Question: Give a one-sentence summary of this figure.
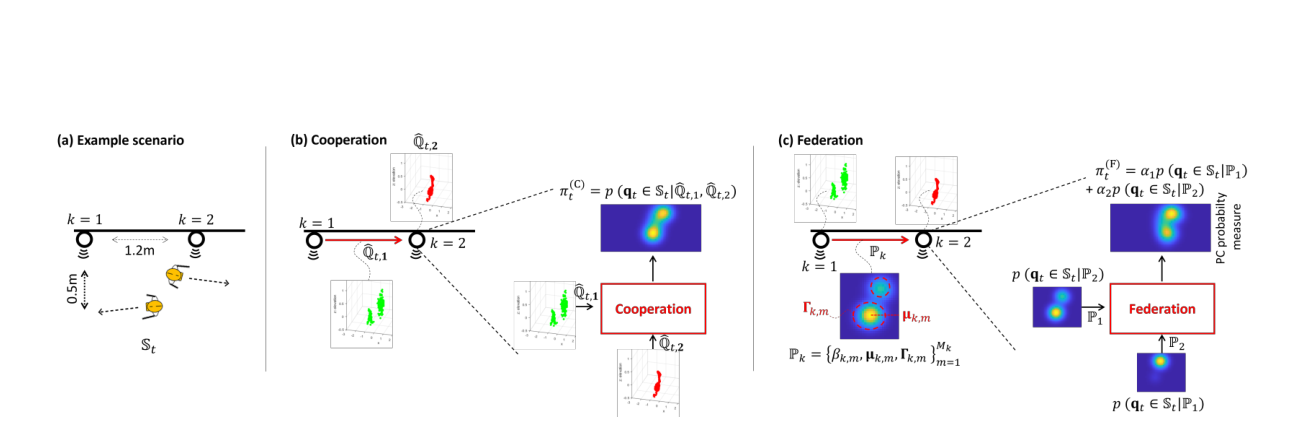
Answer: Cooperation v. Federation PC processing architectures: examples from real data. From left to right: (a) scene St consist of 2 targets co-present and moving in opposite directions with two radars monitoring the same scene; (b) cooperation mode: the radars exchange pre-processed PCs bQt,k and obtain a target probability measure via local fusion of the received PCs; (c) federation mode: the radars exchange the parameters Pk characterizing the local posterior measure approximated as Gaussian mixture (number of Gaussian components Mk, weights βk,m, mean µk,m, and covariance Γk,m of each component m).